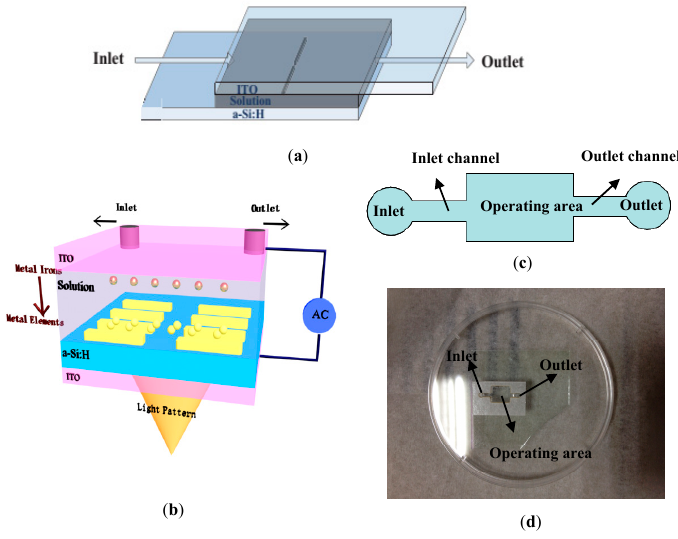
Figure 3. ( a ) Conventional ODEP chip [20]; ( b ) schematic illustration of the structure of the OIED chip; ( c ) pattern to be fabricated on double-sided adhesive tape; ( d ) patterned ITO glass.